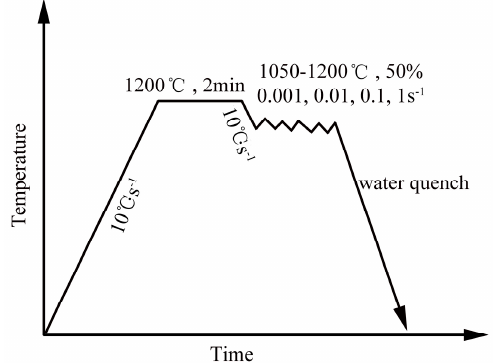
Figure 1. Schematic diagram of hot deformation parameters.